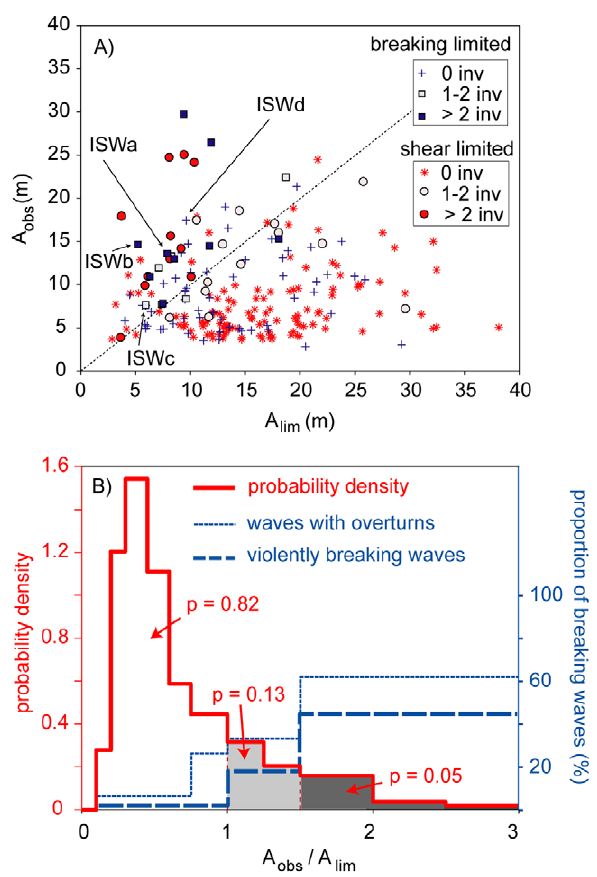
Figure 3. Correlation between the occurrence of ISWs with density inversions and ISWs with amplitudes exceeding their simulated amplitude limits A lim . (A) Scatter plot separating shear (red and circles) and breaking (blue and squares) limited ISWs and showing the correlation between A lim and A obs . The limit, above which breaking is expected, is indicated by the broken line. ISWs with density inversions are depicted as circles and squares, violently breaking waves are intensively coloured. ISWa – ISWd are shown in Fig. 5. (B) Probability to observe waves within ranges of A obs /A lim (red line, denoted as probability density, values for shaded areas are depicted) and probability to observe waves accompanied by density inversions (blue lines, denoted as proportion) within ranges of A obs /A lim